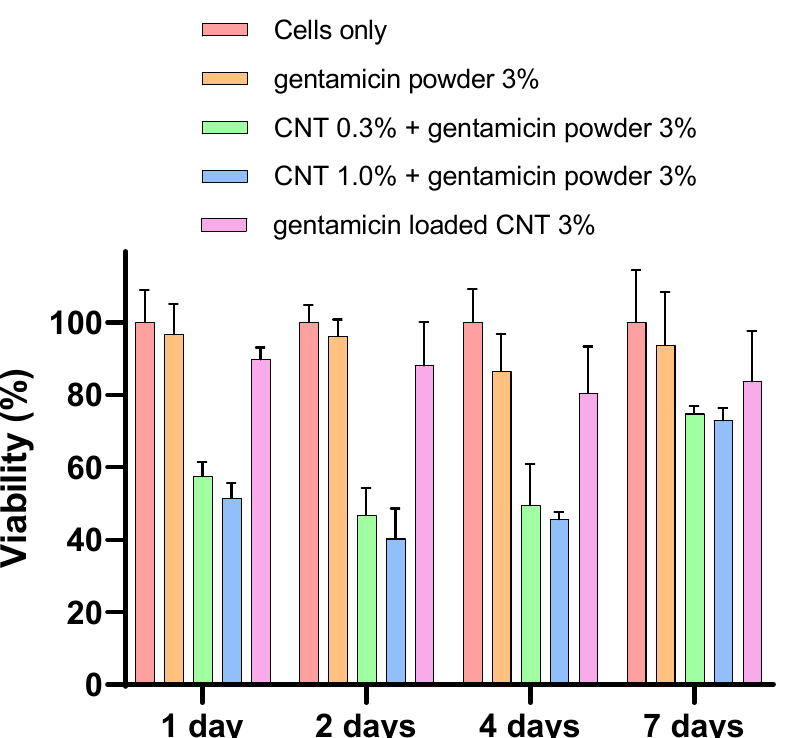
Figure 9. Mitochondrial activity (MTT assay) for osteoblasts with different types of cement ( n = 6 ± SD).